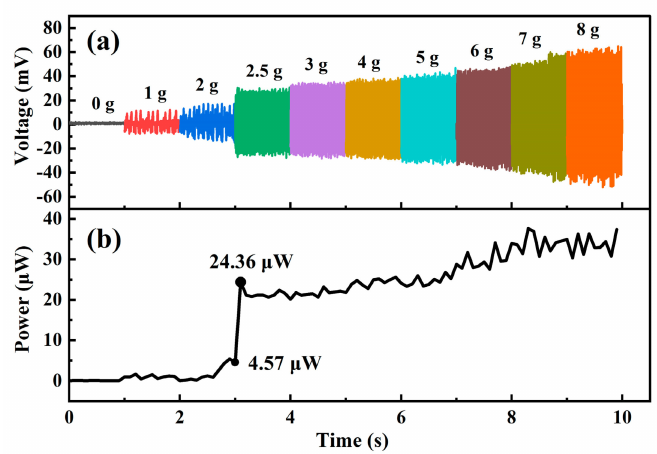
Figure 9. ( a ) Measured transient voltage, and ( b ) averaged power output under different acceleration amplitudes ranged from 0 g to 8 g, where the frequency is fixed as 36